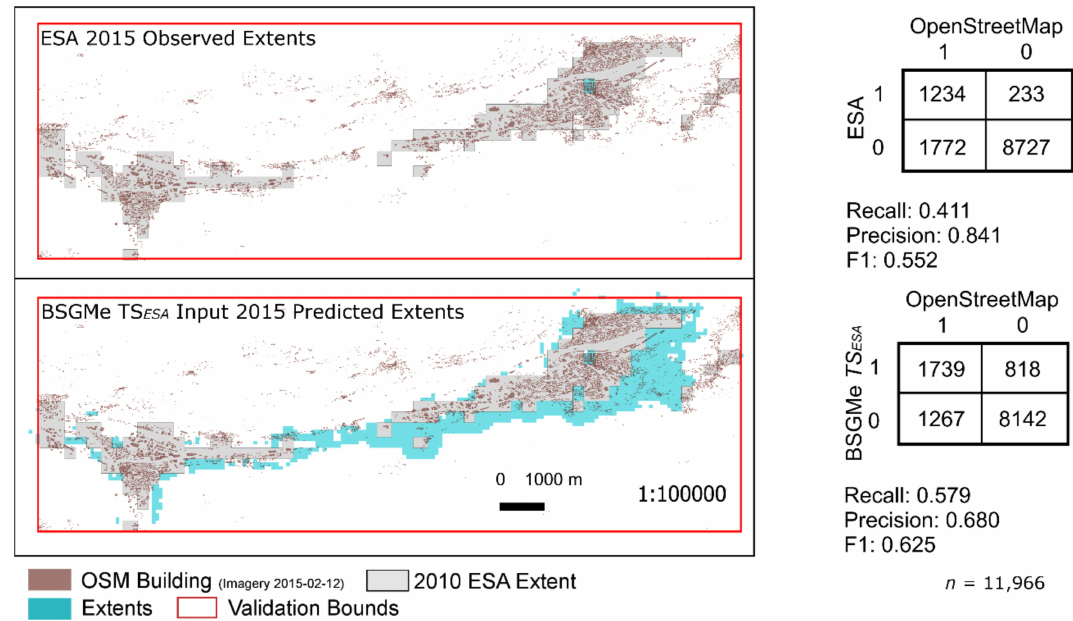
Figure 8. Validation maps of 2015 Open Street Maps (OSM) and manually delineated building footprints of the Visp and Brig area of Switzerland as compared to the ESA RS-derived extents (top left), the BSGMe TS ESA predicted extents (bottom left) along with their corresponding confusion matrices and select classification metrics (right